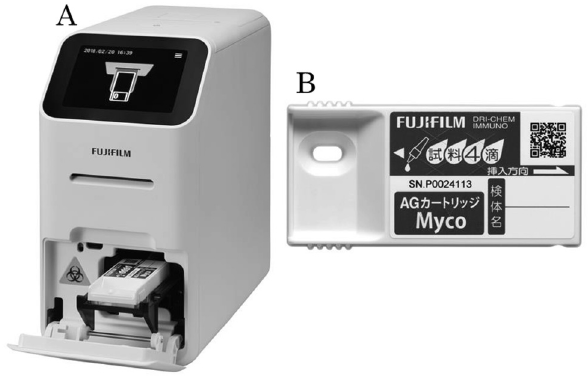
Figure 1: The FUJI DRI-CHEM IMMUNO AG2 (Fujifilm, Kanagawa, Japan) is an analyzer (A). The FUJI DRI-CHEM IMMUNO AG Cartridge Myco(Fujifilm,Kanagawa,Japan)is areagentcartridgefordetection of M. pneumoniae